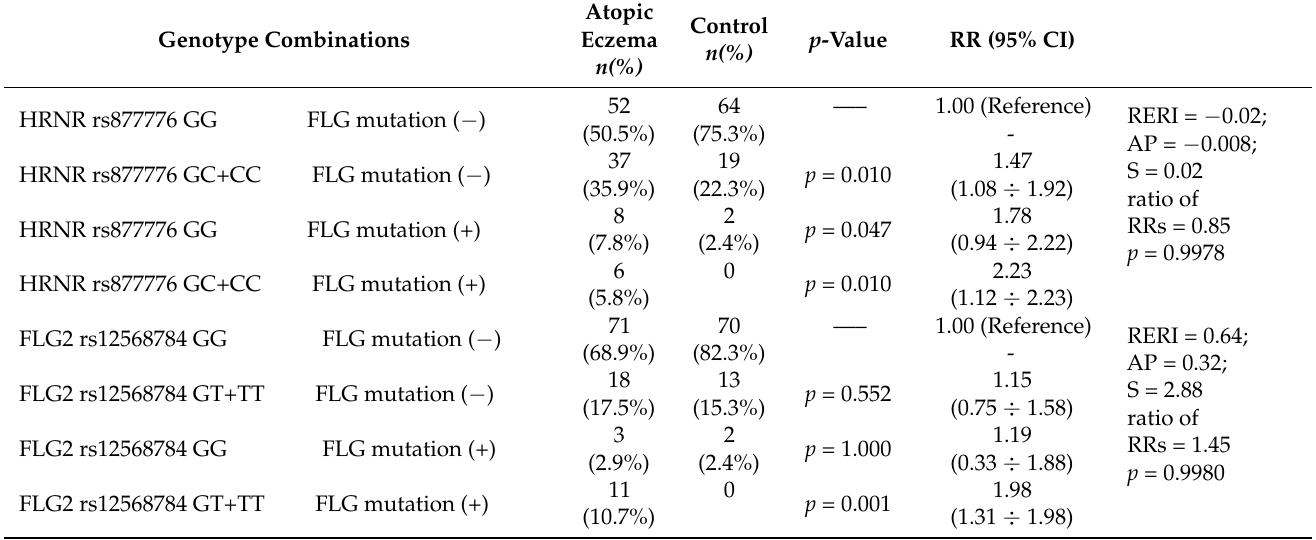
Table 5. Interaction between HRNR rs877776 and FLG2 rs12568784 and the FLG mutations in atopic